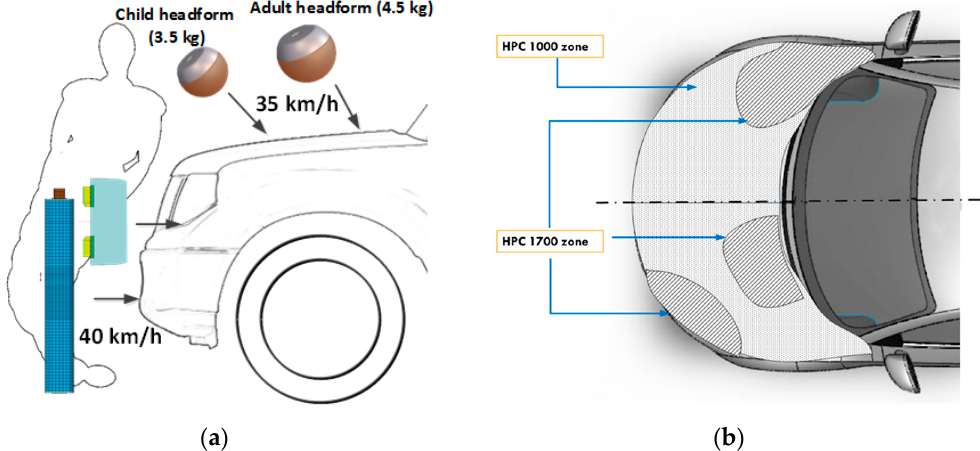
Figure 3. ( a ) Visualization of a vehicle-to-pedestrian accident and the use of impactors that represent critical parts of the human body; ( b ) determination of head impact zone—according to Regulation (EC) 78/2009, phase II.